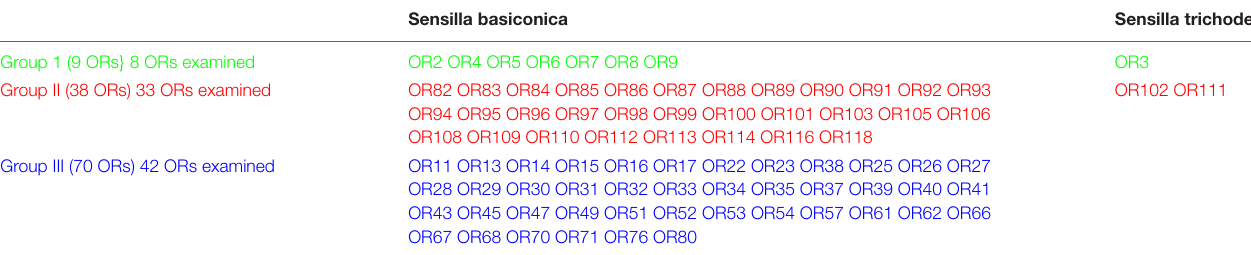
TABLE 1 | Summary of the sensilla specific expression for 83 receptor types.